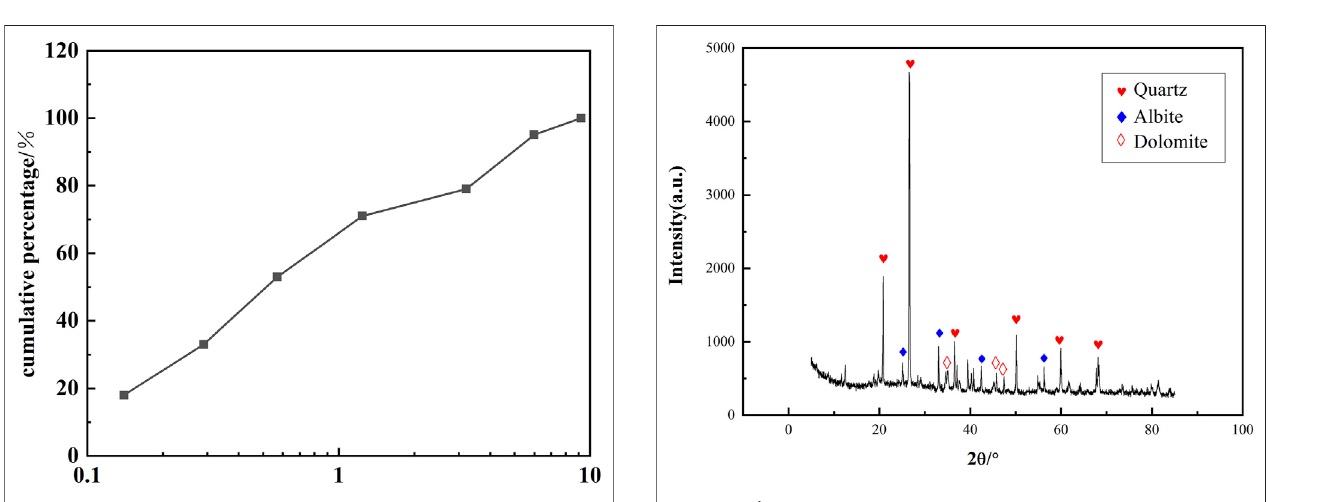
FIGURE 4 | Mineral composition of tailings. TABLE 1 | Chemical composition of cement.